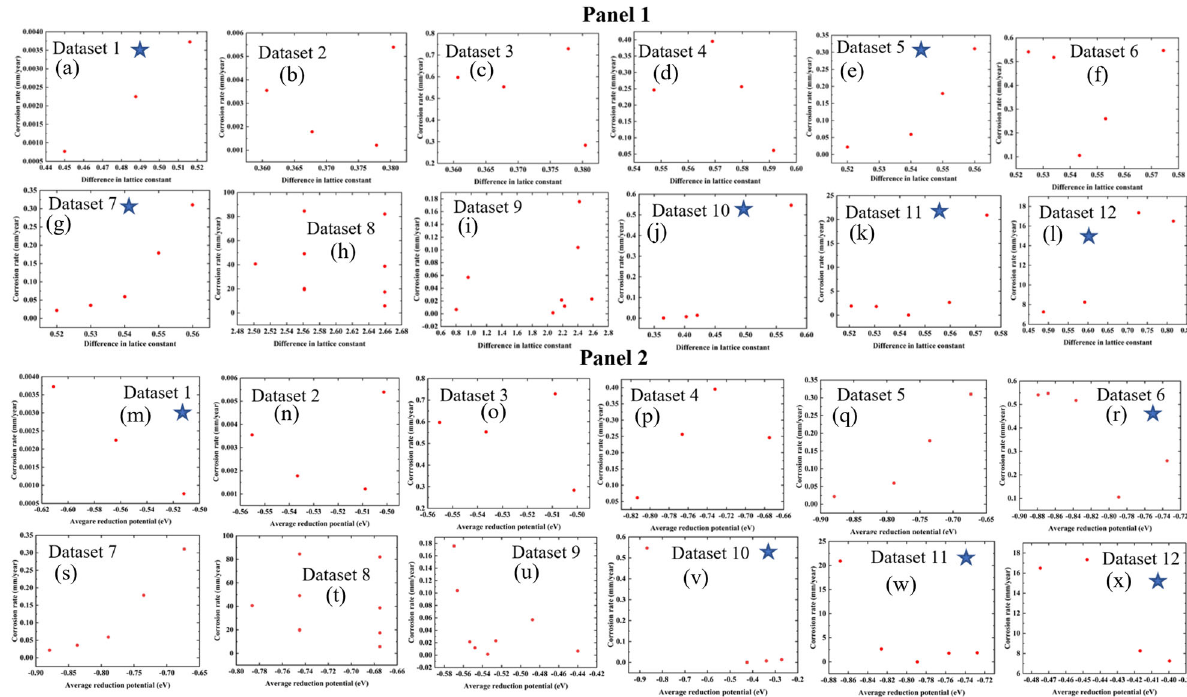
Fig. 5 Trends of corrosion rate with respect to 2 of the 5 down selected features. The corrosion rate of 12 MPEA datasets as a function of the difference in lattice constant and average reduction potential (eV) are presented in panel 1, (a – l) and panel 2, (m – x), respectively. The star mark in each panel indicates the datasets which are in agreement with our reasoning. Since the prediction of the ML model is based on the combined effect of the 5 down select features, the corrosion rate does not show a clear trend in some plots when plotted individually with the selected features. Details of the datasets are provided in Supplementary Table 1.